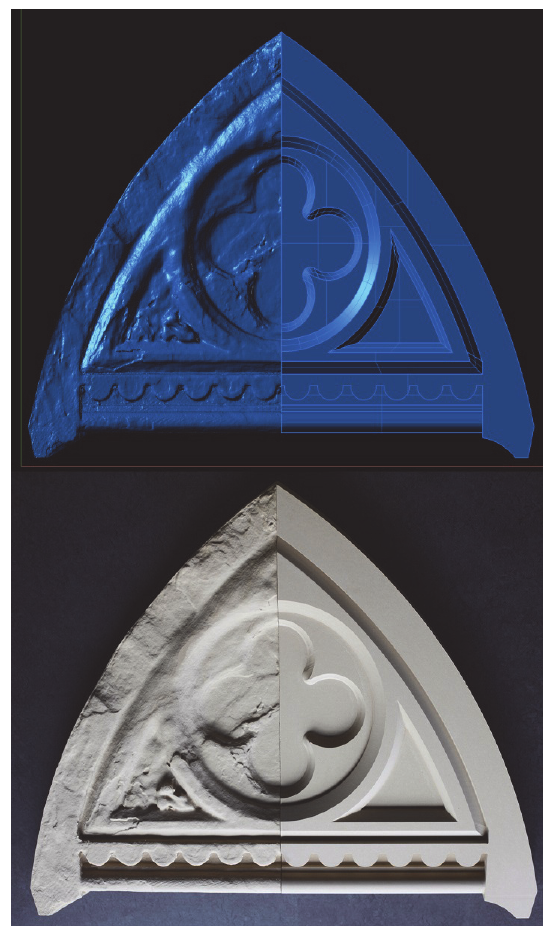
Figure 4. Polygon mesh model of tympanum (top) and CNC milled tympanum maquette (bottom)